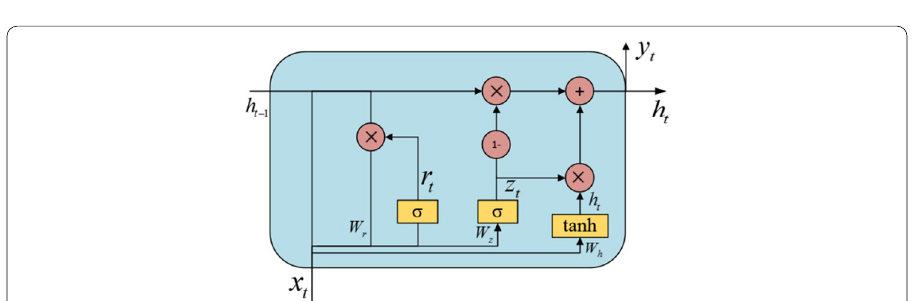
Fig. 3 Gated recurrent